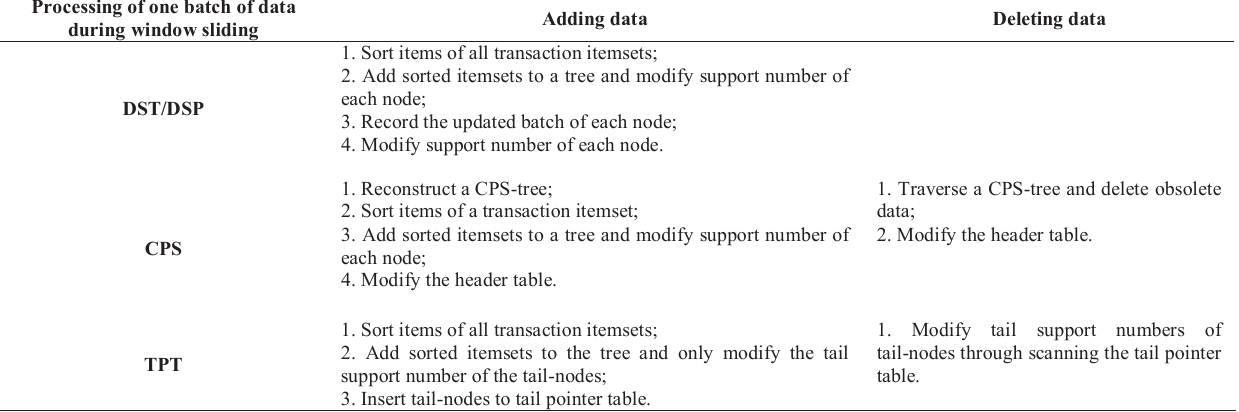
Table 1. Differences in data processing methods among the three